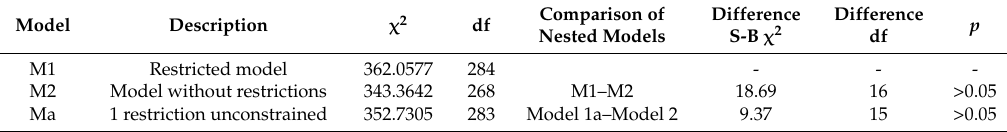
Table 4. Tests of measurement invariance across two samples for the two-factor model.